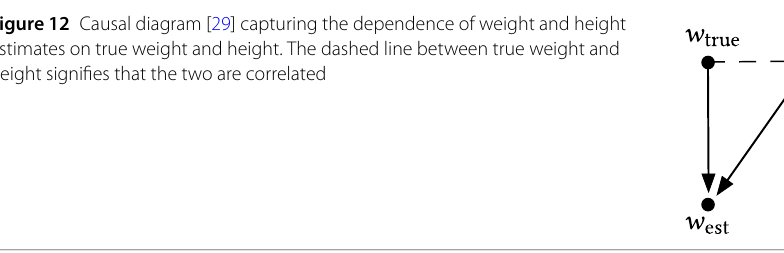
Figure 12 Causal diagram [29] capturing the dependence of weight and height estimates on true weight and height. The dashed line between true weight and height signifies that the two are